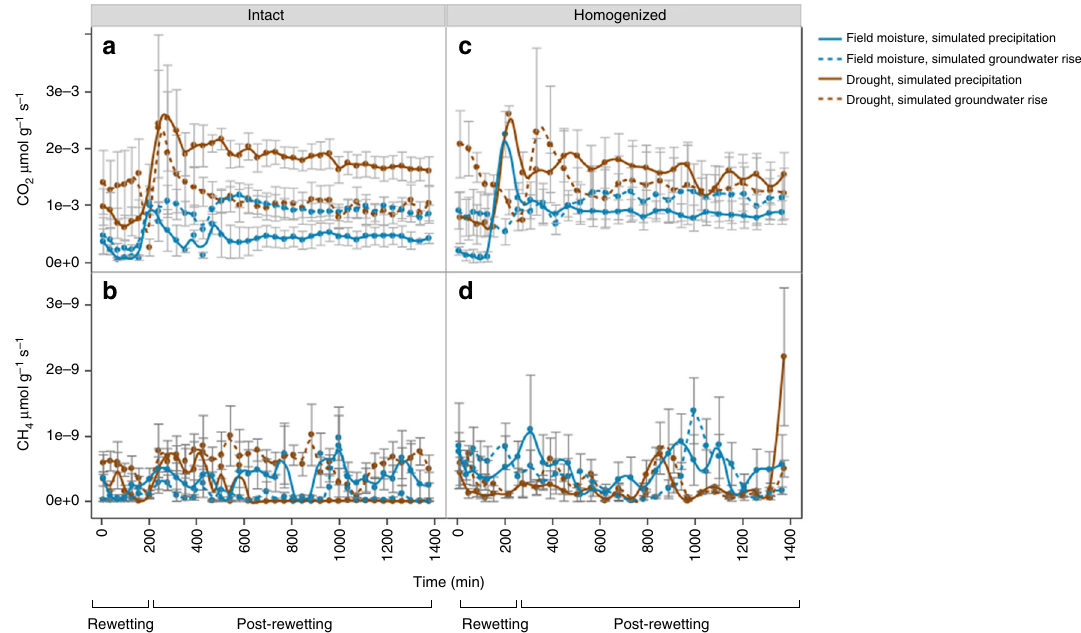
Fig. 4 Core-scale carbonaceous greenhouse gas measurements throughout rewetting and post-rewetting incubation. CO 2 ( μ mol g − 1 s − 1 ) respiration rates from a intact or b homogenized cores, and CH 4 ( μ mol g − 1 s − 1 ) respiration rates from c intact or d homogenized cores, during rewetting (200 min) and 20 h following rewetting event; wet from above (simulated precipitation) or wet from below (simulated groundwater rise) for cores maintained at fi eld moisture content or subjected to laboratory-induced antecedent drought cores. Solid lines represent cores from simulated precipitation, whereas dashed lines represent cores from simulated groundwater rise treatments. Bars represent standard error for n = 4 cores, with the exception of homogenized cores subjected to antecedent drought and wet from below where n = 3. Statistical summaries for cumulative CO 2 − C and CH 4 − C are included as Table